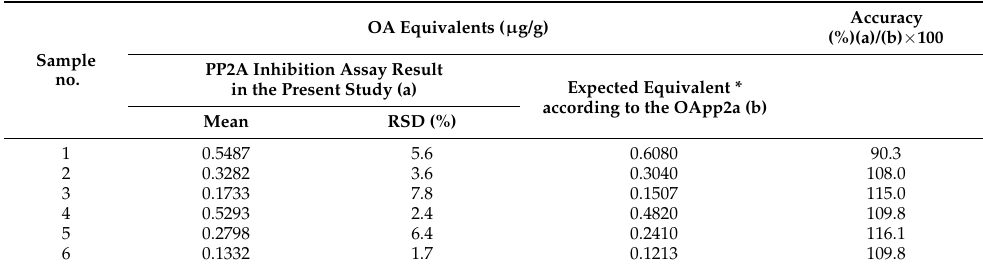
Table 3. OA equivalents ( µ g of OA eq /g whole meat) determined by PP2A inhibition assay and expected according to the